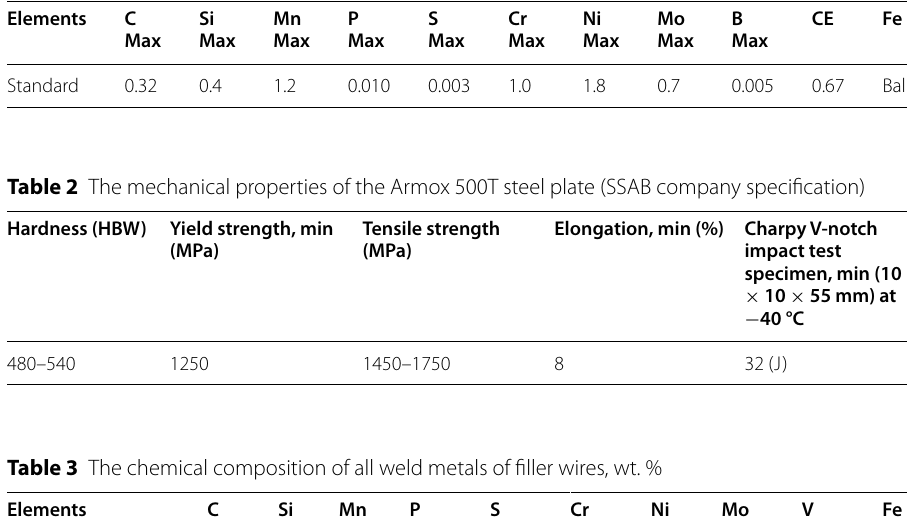
Table 1 Chemical compositions of the Armox 500T steel plate (SSAB company specification), wt.% Nominal composition % Elements Standard